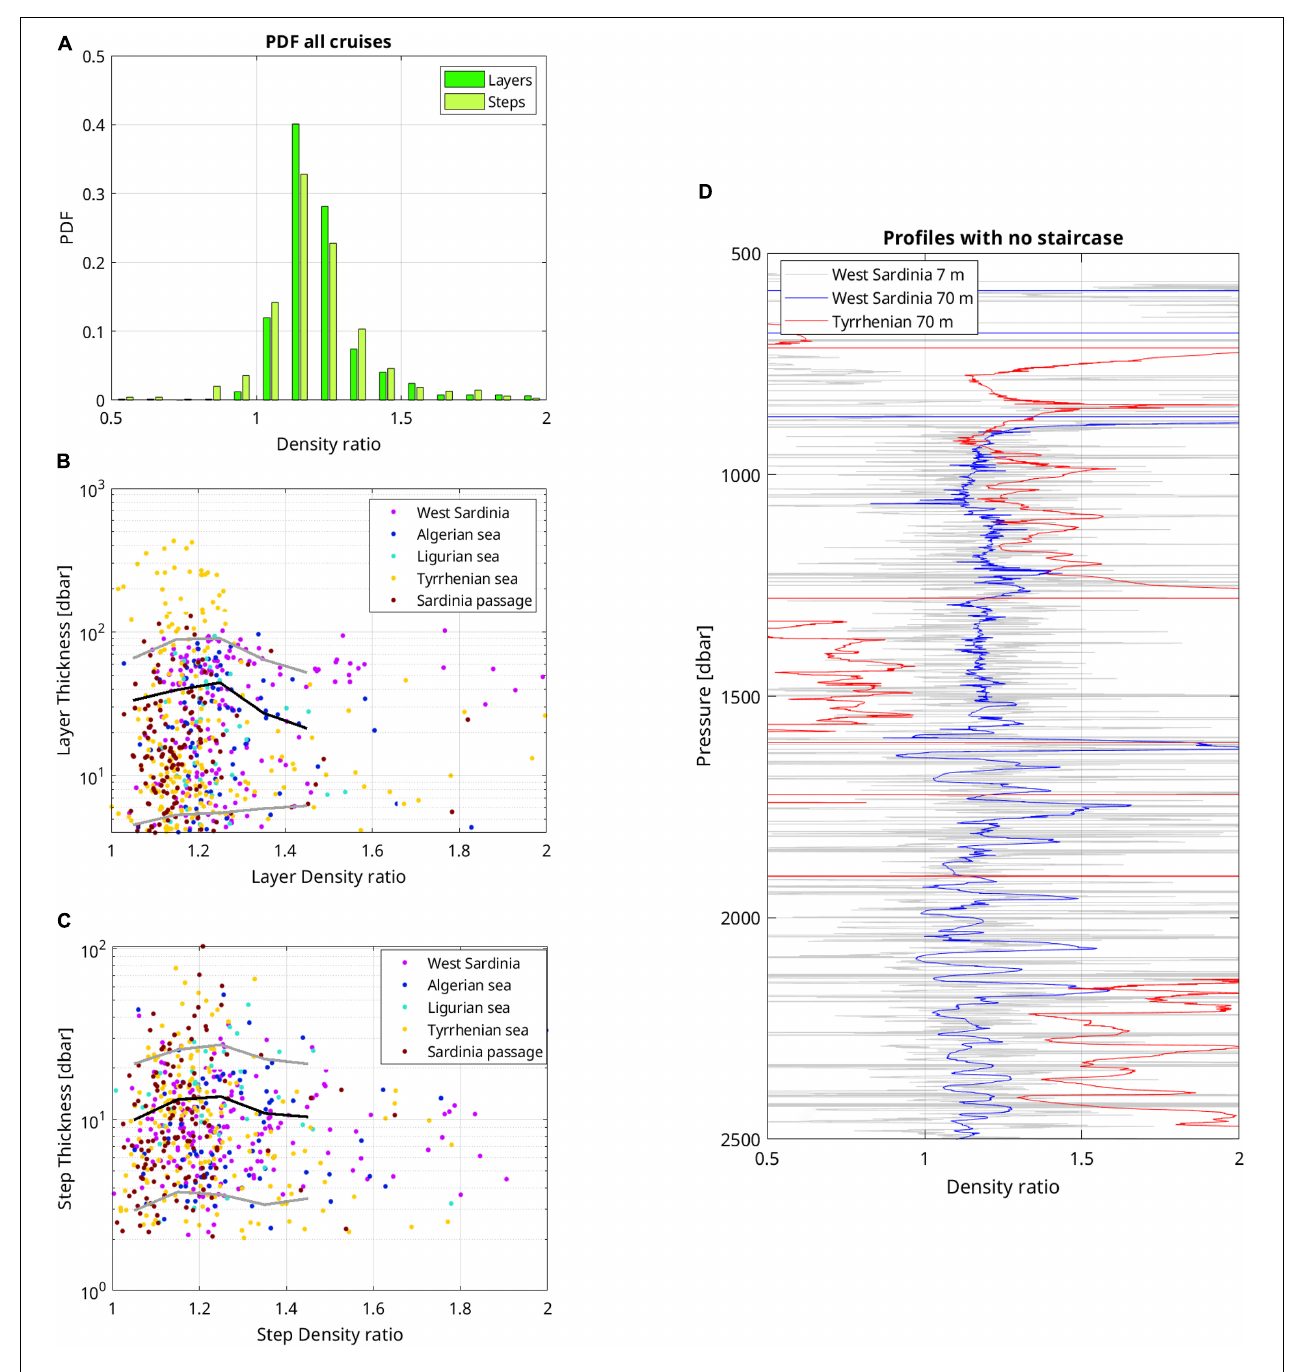
FIGURE 6 | Properties associated with density ratios R ρ : (A) PDF of R ρ for layers and steps, (B) relationship between layer thickness (log scale) and R ρ by region (dots) with the overall mean (black line) and 10th- and 90th-percentile (gray lines) for bins having at least 30 members, (C) same as (B) for step thickness, (D) examples from VENUS 2013 cruise of density ratio profiles from two selected stations showing no staircase: sta. #12 (west Sardinia) along the Minorca-Sardinia transect, and sta. #21 in the southern Tyrrhenian (magenta numbers on Figure 1 ). The calculation of the R ρ -profile is done with two depth intervals (7 m and 70 m).